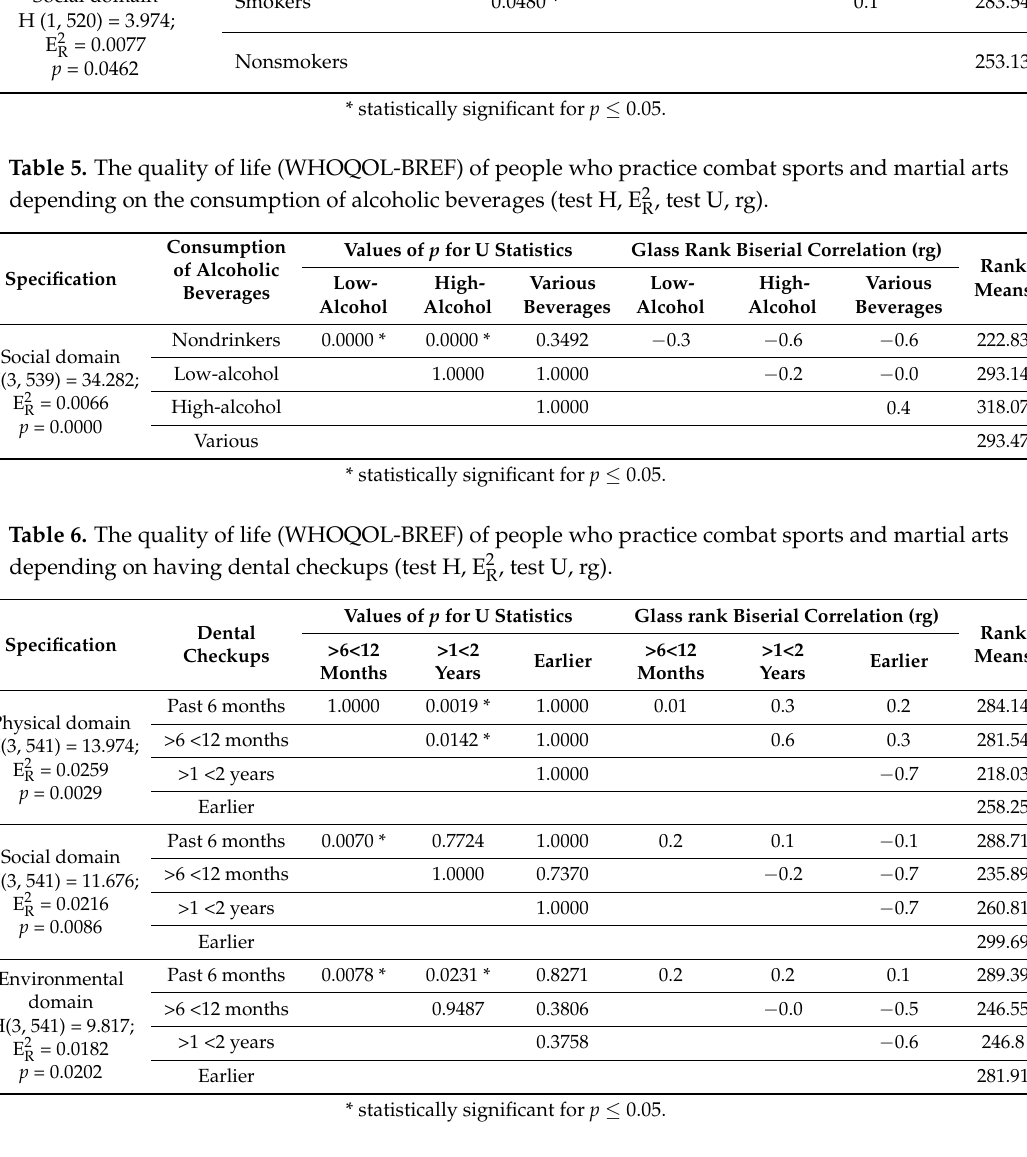
Table 4. Satisfaction with health and the quality of life (social domain) (WHOQOL-BREF) of people who practice combat sports and martial arts, depending on smoking (test H, E 2 Specification